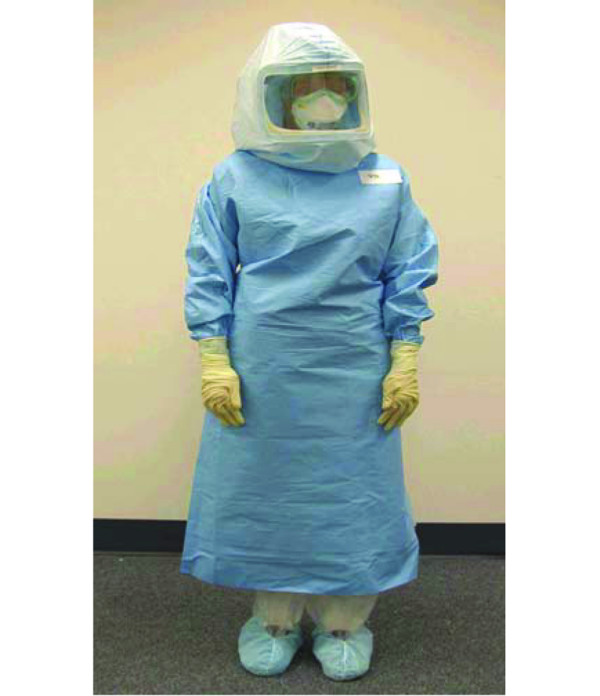
Healthcare worker dressed in T4 Stryker personal protection system (PPS). The PPS is worn over a disposable gown. In addition, goggles, an N95 respirator and two pairs of gloves are worn.